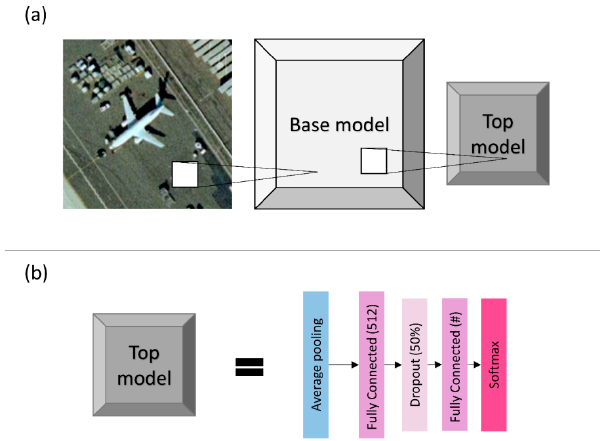
Figure 1. Visualization of the models used. ( a ) shows a sample image from UCMerced, the base model, and the top model. ( b ) provides more details for the top model. The base model is dependent on the convolutional neural network (CNN) architecture used for transfer learning and it is detailed in Figure 2. Top model is the same for all experiments. Note the pound sign “#” represents the number of classes, which depends on the dataset used.